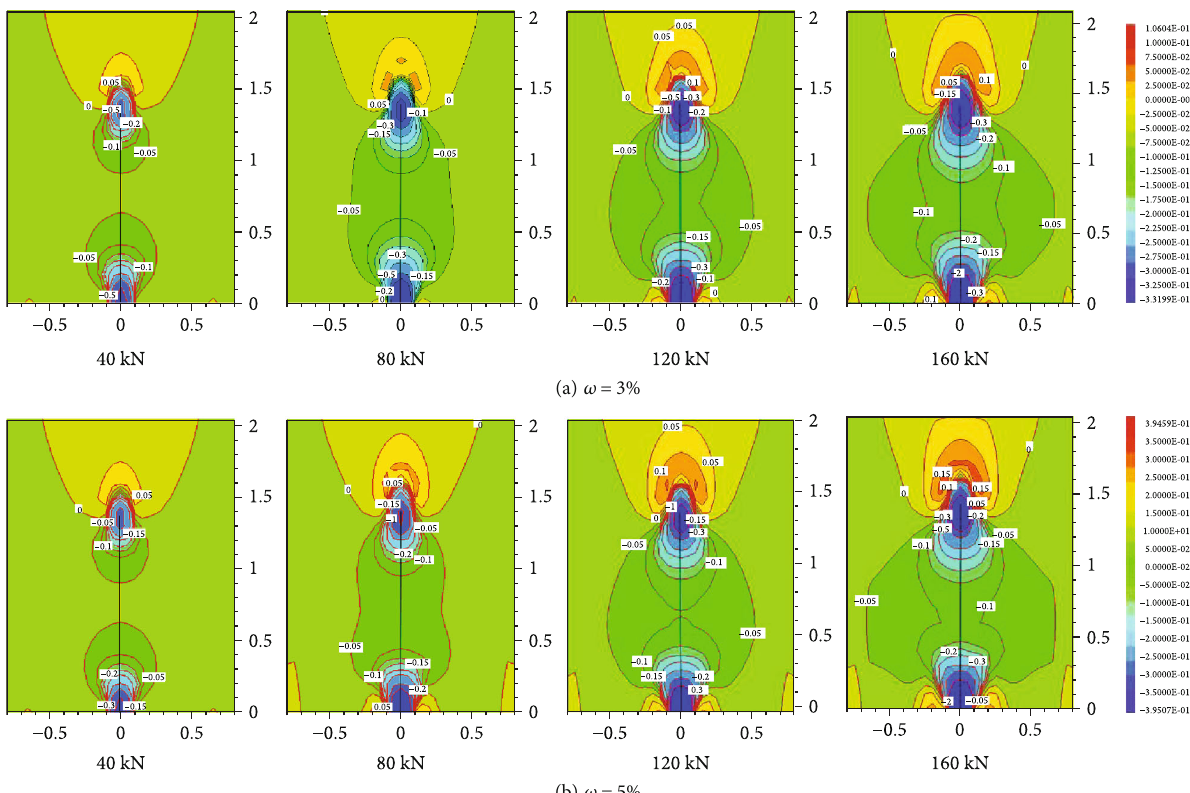
Figure 8: Supporting stress contour in di ff erent